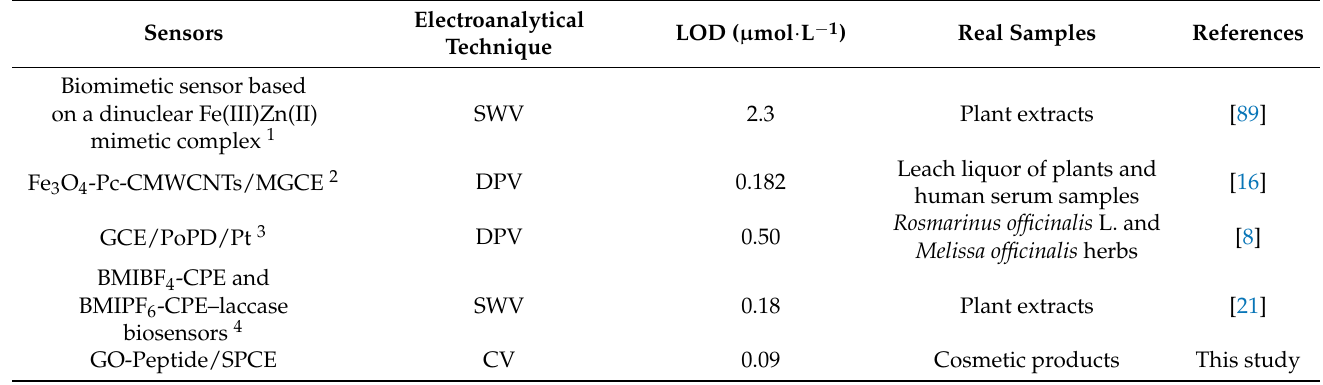
Table 2. Performance characteristics of several electrochemical sensors in the detection of rosmarinic